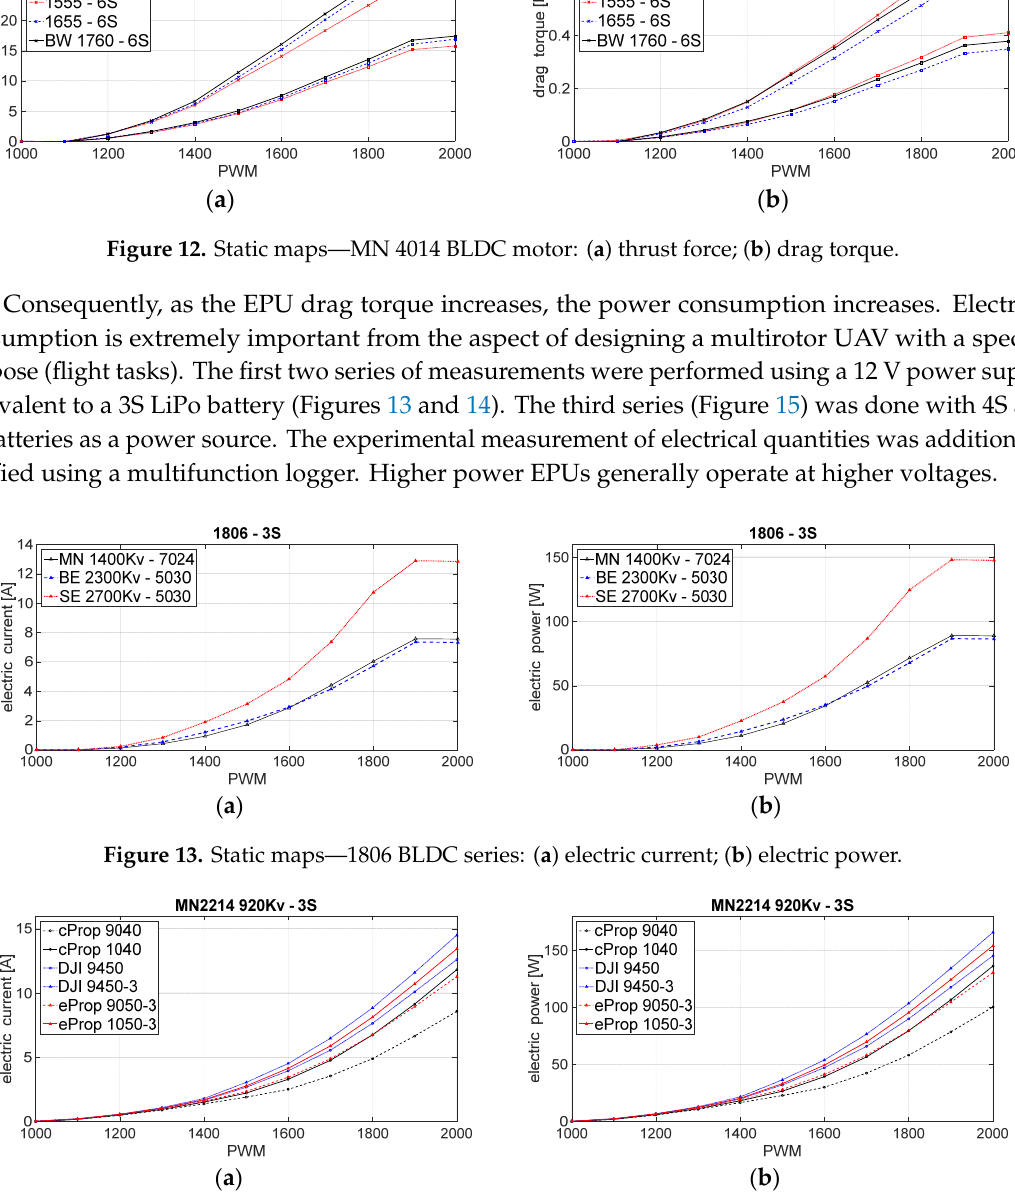
Figure 14. Static maps—MN 2214 BLDC motor: ( a ) electric current; ( b ) electric power.